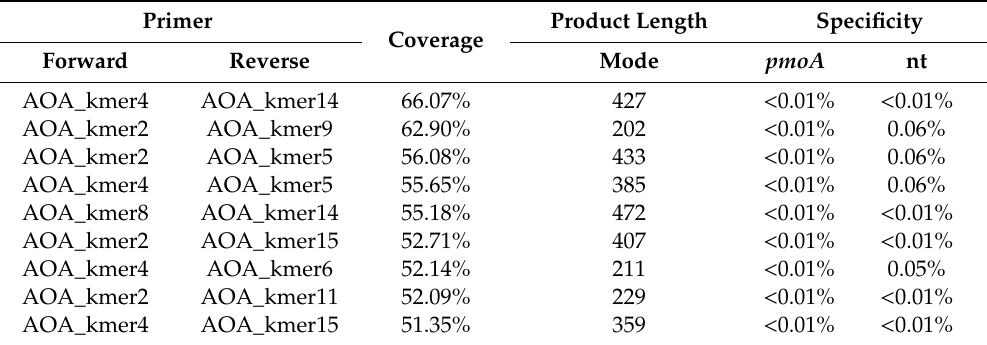
Table 2. Recommended primer sets for amoA gene of AOA.